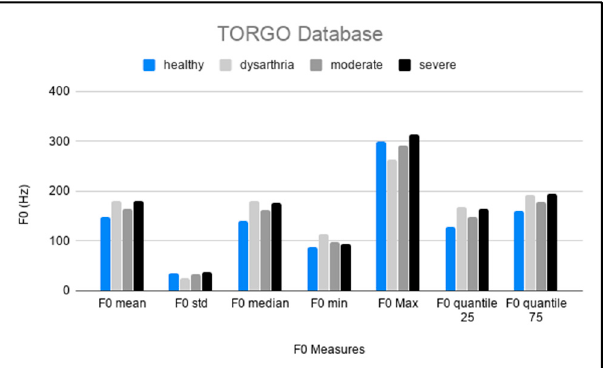
Figure 2. The mean values of all F0 measurements from the TORGO dataset.